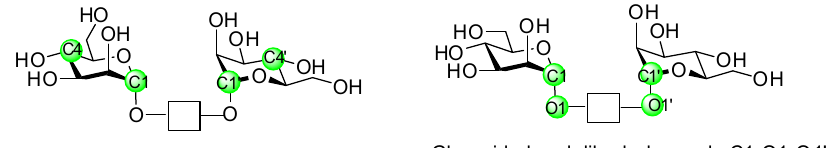
Figure 6. Scatter plots of data for selected conformers of compounds 1 – 4 as generated from molecular dynamics simulations using Macromodel 8.0. The definitions of distance between mannose units, glycoside bond dihedral and core dihedral are shown at the